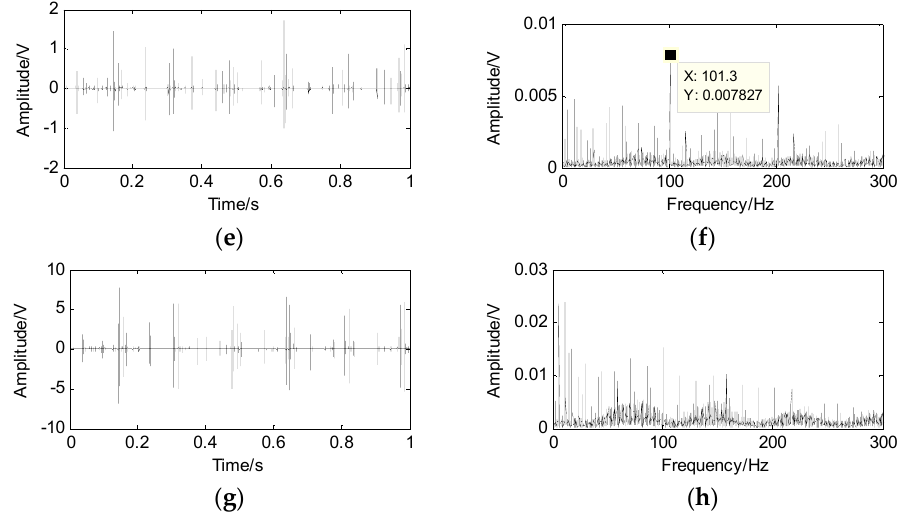
Figure 10. The wavelet modulus maxima of the second mixed signal and its spectrum. ( a ) wavelet modulus maxima of the first level; ( b ) the spectrum of the first level; ( c ) wavelet modulus maxima of the second level; ( d ) the spectrum of the second level; ( e ) wavelet modulus maxima of the third level; ( f ) the spectrum of the third level; ( g ) wavelet modulus maxima of the fourth level; ( h ) the spectrum of the fourth level.